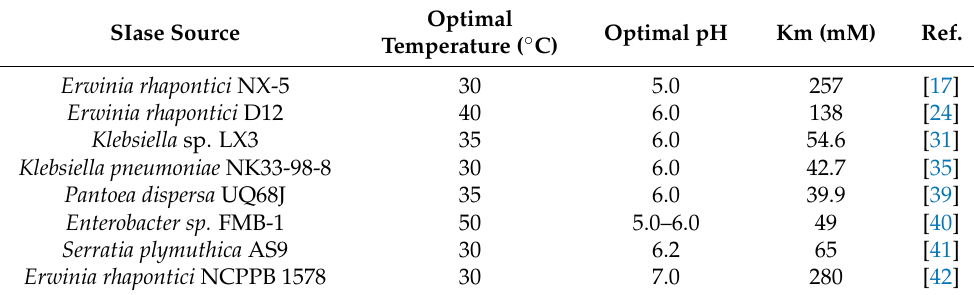
Table 4. Characteristics of purified SIases from various microorganisms. SIase